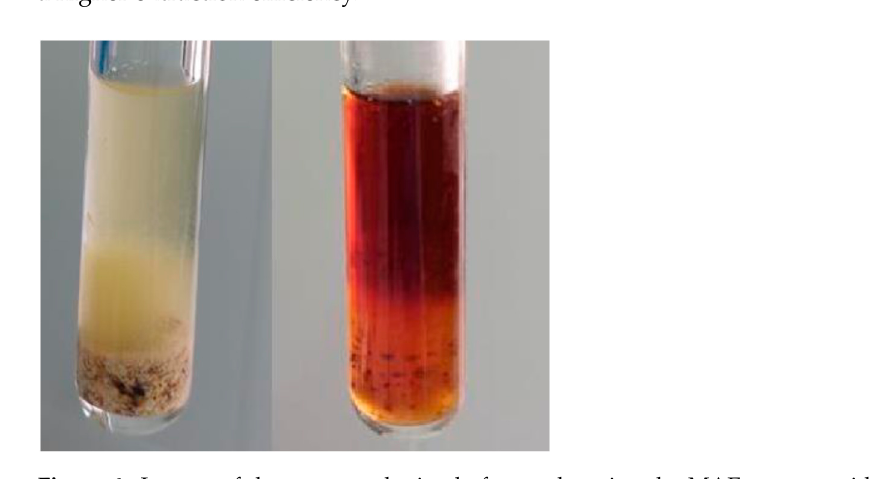
Figure 5. Antioxidant activity of the extracts according to the orbital shaker extraction (OSE) or mi- crowave-assisted extraction (MAE) method used and as a function of the evaluated solvent (Et30DW or Bet: 2But [1:4]). Results are expressed as mean values (% DPPH inhibition) ± RSD (%).